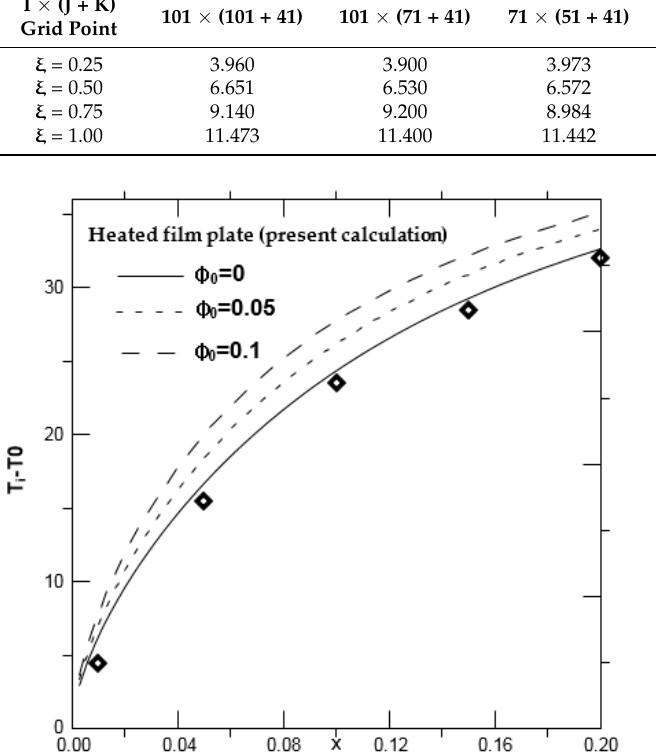
Figure 2. Comparison of the temperature at the interface with that of Yan et al. [14].